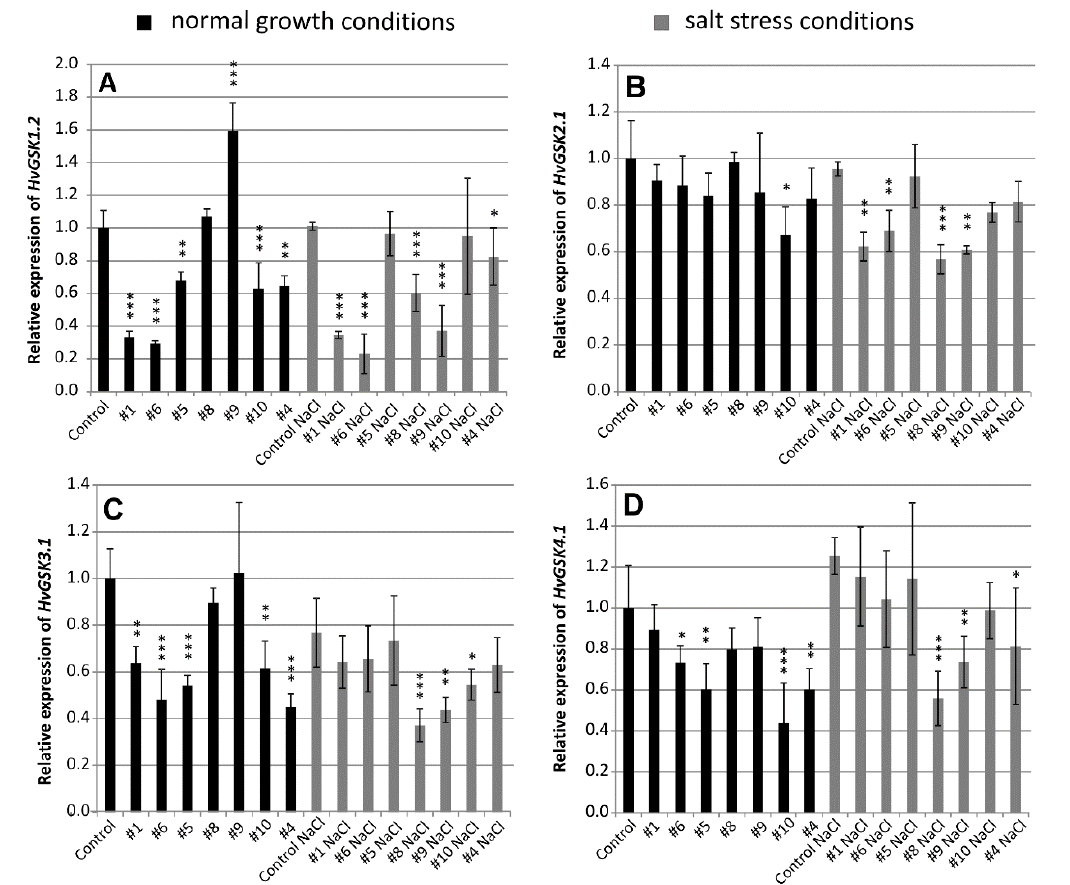
Figure 2. Relative expression of HvGSK paralogs HvGSK1.2 ( A ), HvGSK2.1 ( B ), HvGSK3.1 ( C ), and HvGSK4.1 ( D ) in leaves of T 4 plants of transgenic lines grown in normal (Hoagland medium, black plots) and in salt stress conditions (Hoagland medium supplemented with NaCl 200 mM, grey plots). Relative expression of each of the tested paralogs in non-transgenic control plants grown in normal conditions was assumed as 1.0. The ADP-ribosylation factor (ARF) AJ508228 was used as the reference gene. Data represent mean values and standard deviation of at least three biological replicates with three technical repetitions. Indicated are significant differences between the control and the line grown in the same conditions: * p < 0.05, ** p < 0.01, *** p < 0.001.